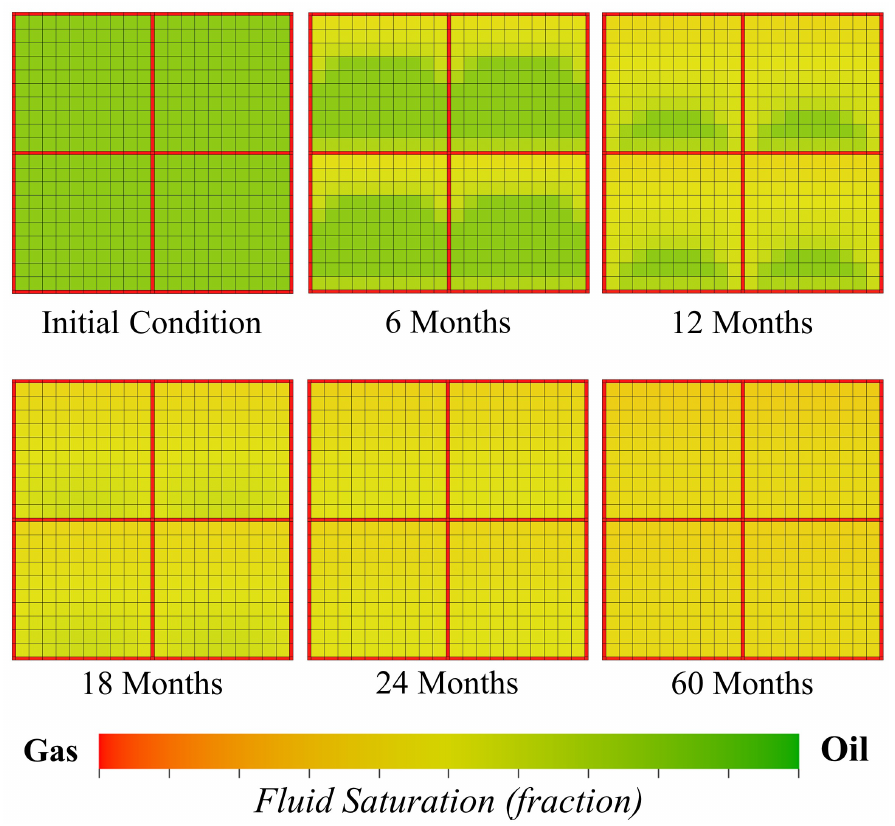
Figure 12. Oil and gas saturation of the fine model for several intervals starting from the initial condition, 6, 12, 18, 24, and 60